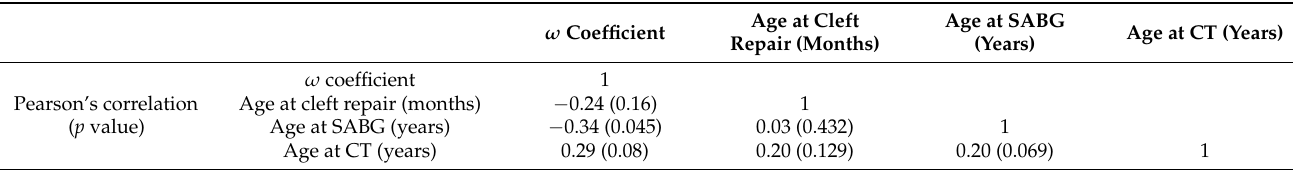
Table 2. Pearson’s correlation univariate analysis results between ω coefficient, age at cleft repair, age at SABG, and age at CT.